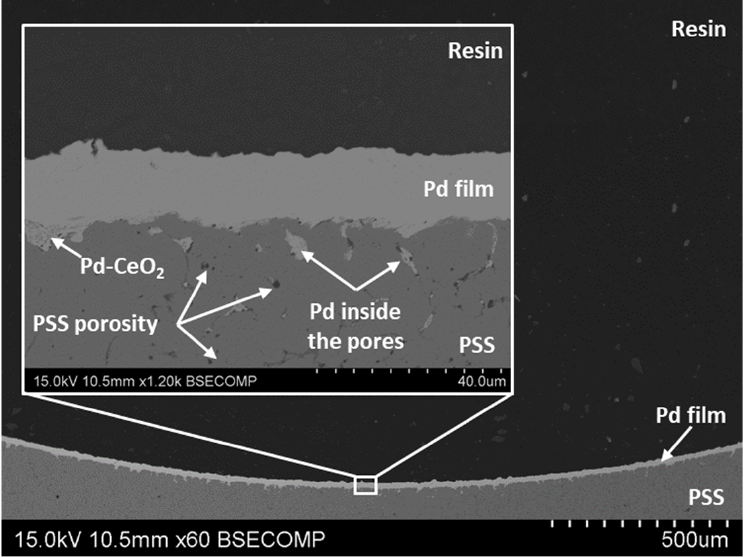
Figure 4. SEM micrographs of Pd–CeO 2 intermediate layer reached on contrary sides of calcined PSS supports: ( a ) external and ( b ) internal.